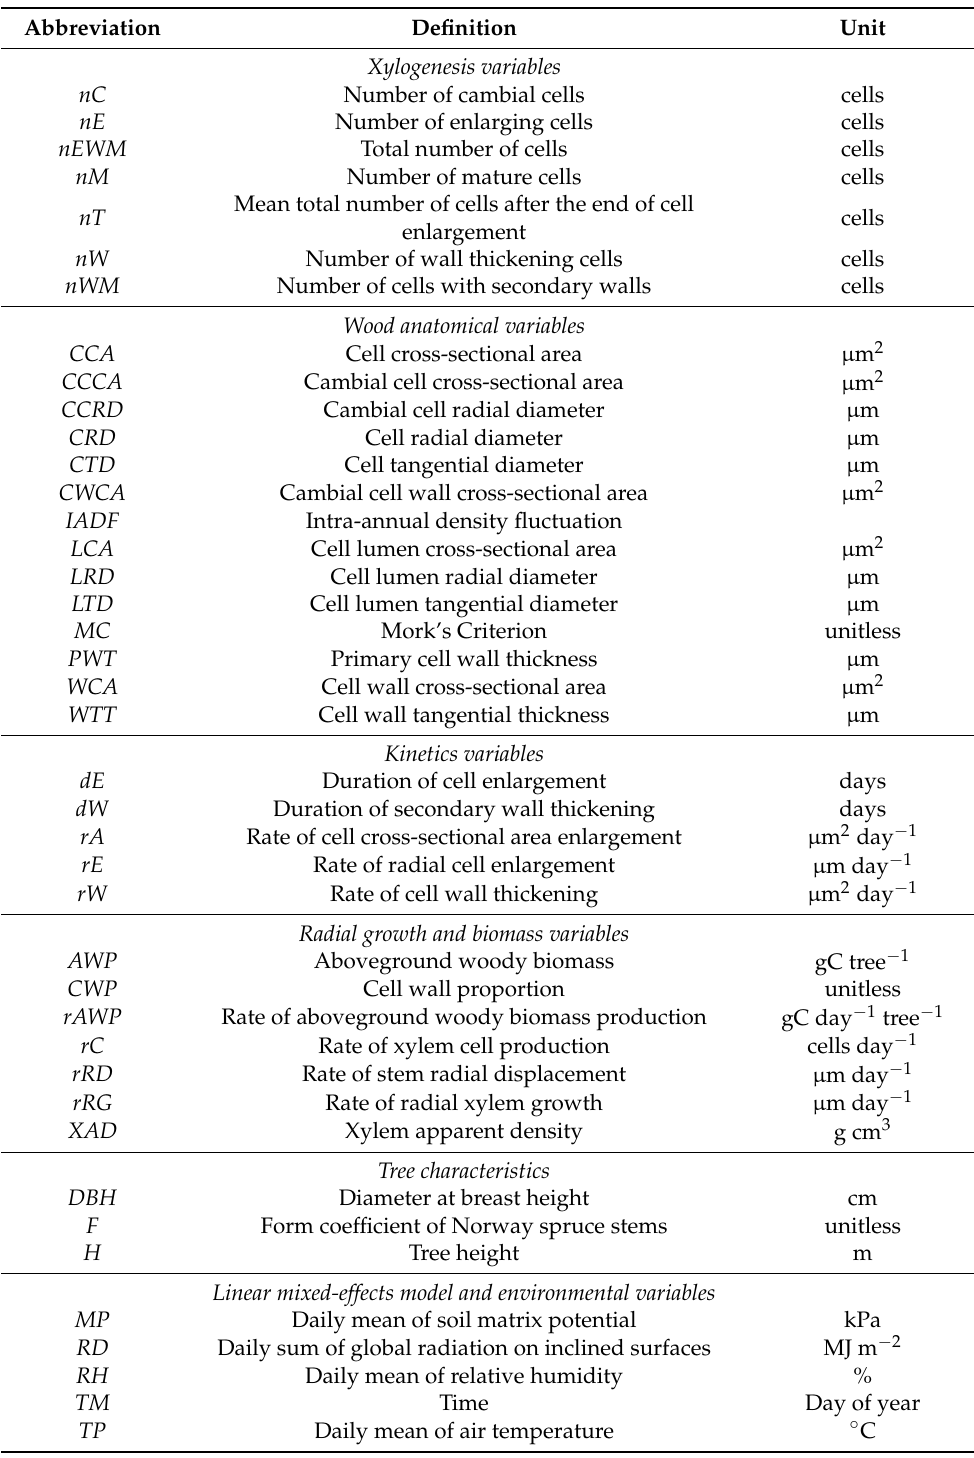
Table A1. List of abbreviations used in this study with their definitions (and units where